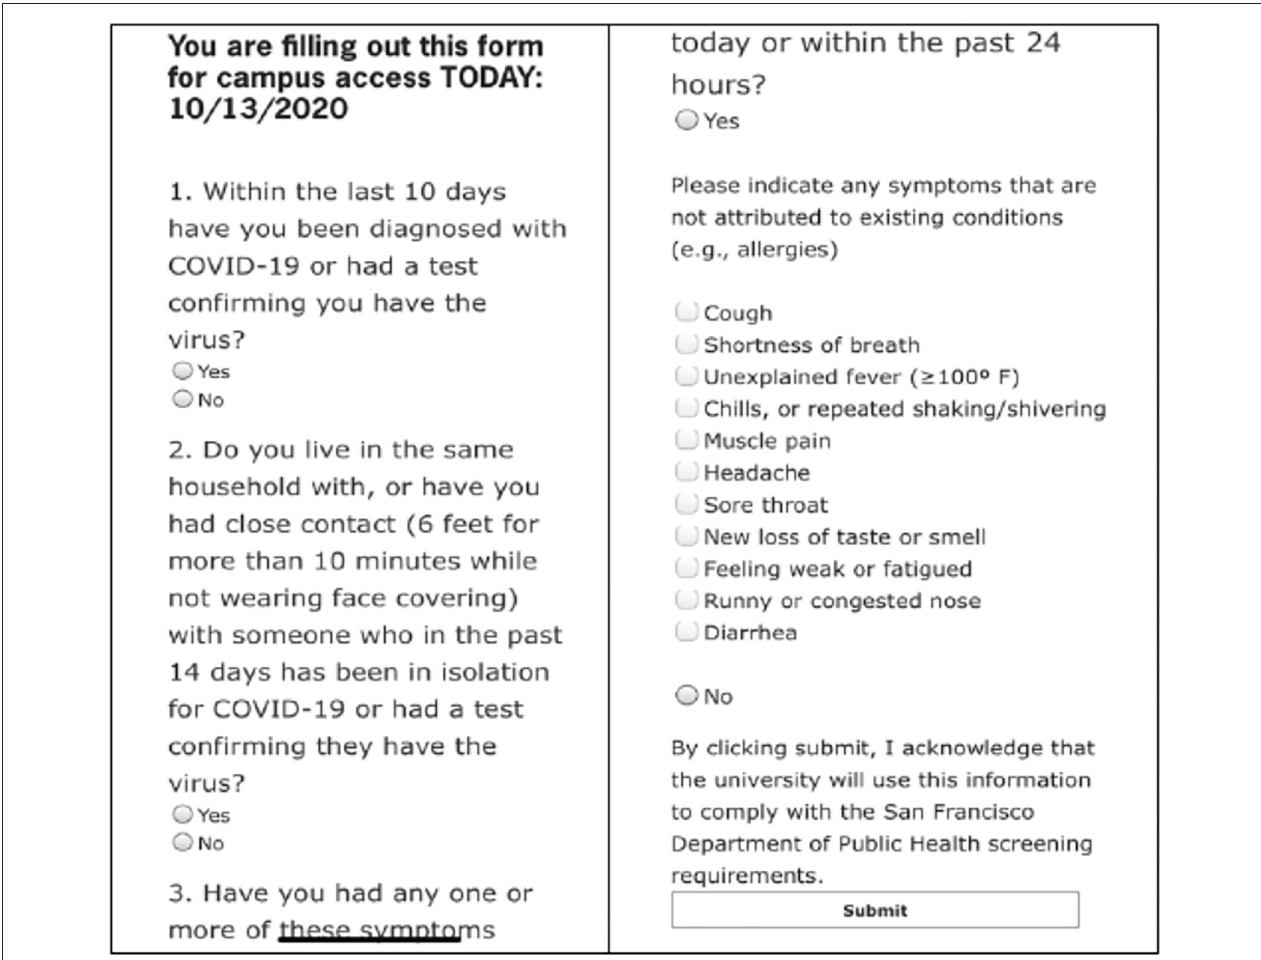
FIGURE 2 | Example screening form from the University of the Pacific.